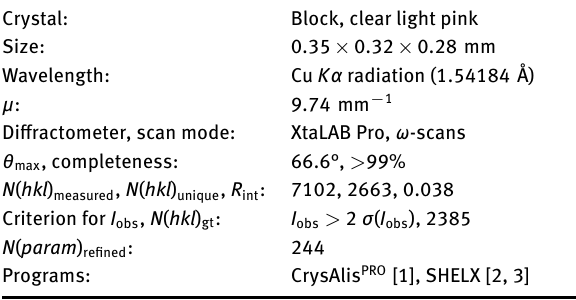
Table 2: Fractional atomic coordinates and isotropic or equivalent isotropic displacement parameters (Å 2